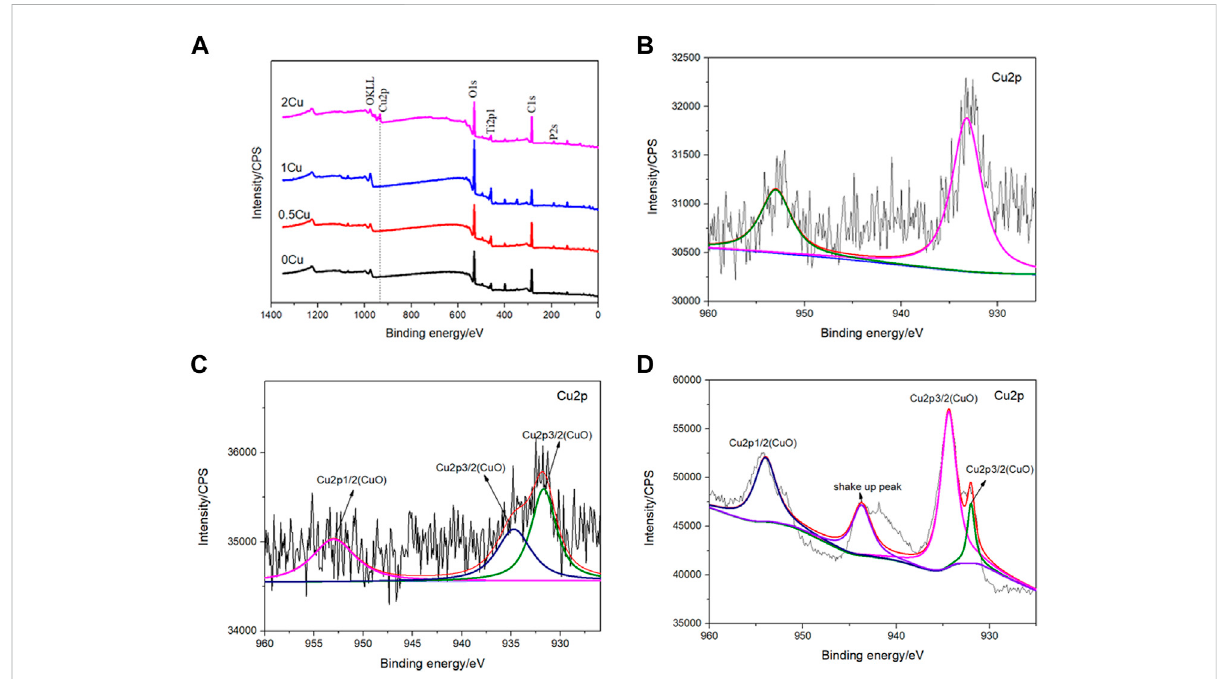
FIGURE 4 XPS survey spectrum (A) and Cu2p high-resolution spectra of the 0.5Cu-MAO (B) ,1Cu-MAO (C) , 2Cu-MAO (D) coating.